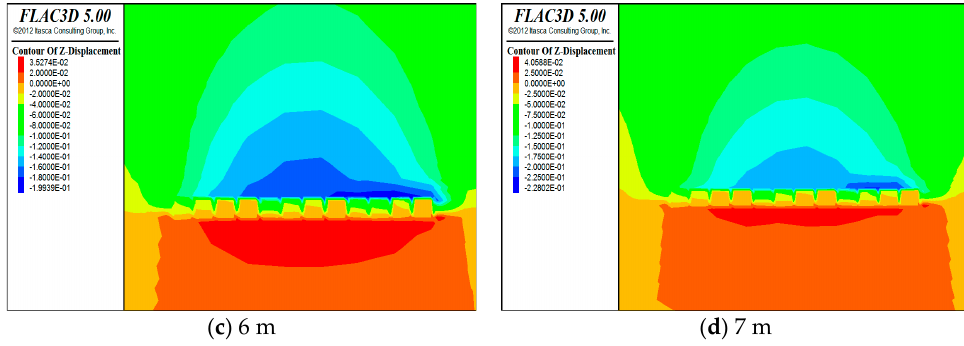
Figure 9. Vertical displacement cloud for ( a ) 4 m, ( b ) 5 m, ( c ) 6 m, and ( d ) 7 m.